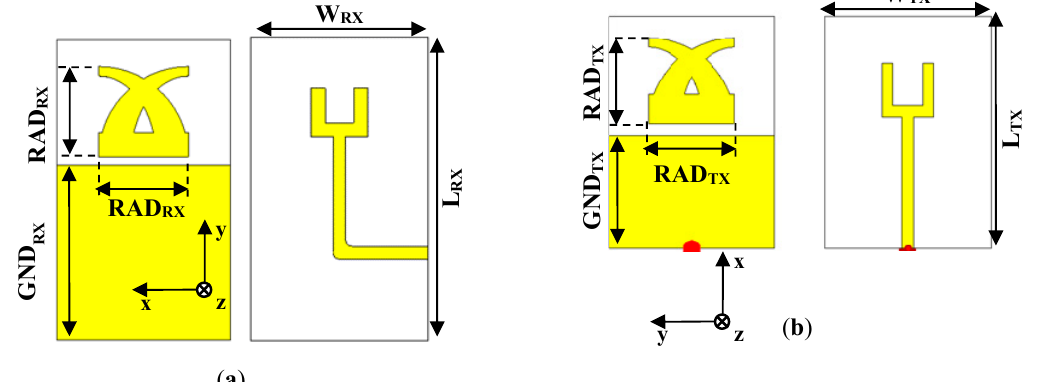
Figure 5. Geometries and dimensions of the wideband antennas proposed as RX tag antenna ( a ) and TX tag antenna ( b ). Table 1. Dimensions of the antennas illustrated in Figure 5.